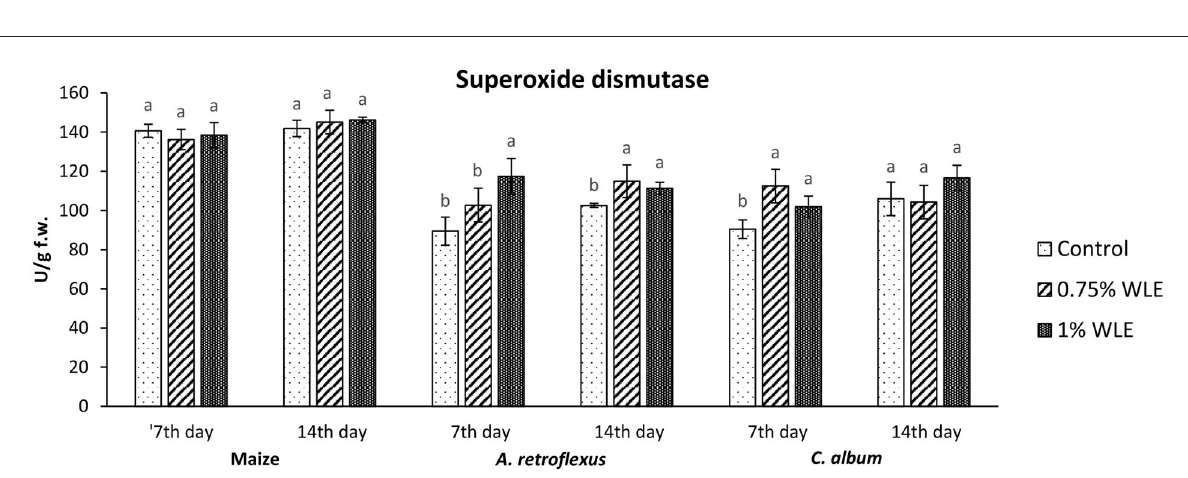
FIGURE3 Activity of antioxidant enzyme superoxide dismutase (SOD) in maize and weeds - Amaranthus retroflexus and Chenopodium album as a response to treatment with 0.75 and 1% walnut leaf extract, on the 7 th and 14 th day after treatment. Data are presented as mean ± SD. Values marked with different letters within a group differ significantly based on Tukey’s HSD test ( p ≤